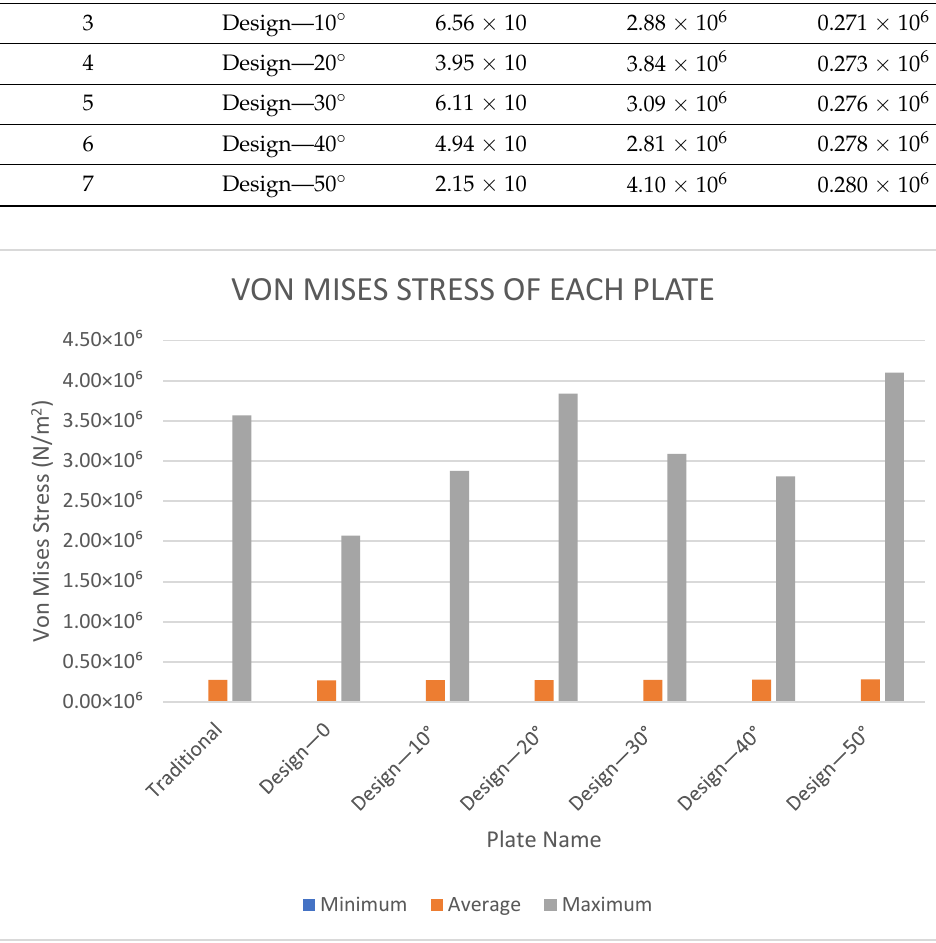
Figure 28. Von Mises stress (N/m 2 ) of each plate. Table 4. First principal strain (1) of each